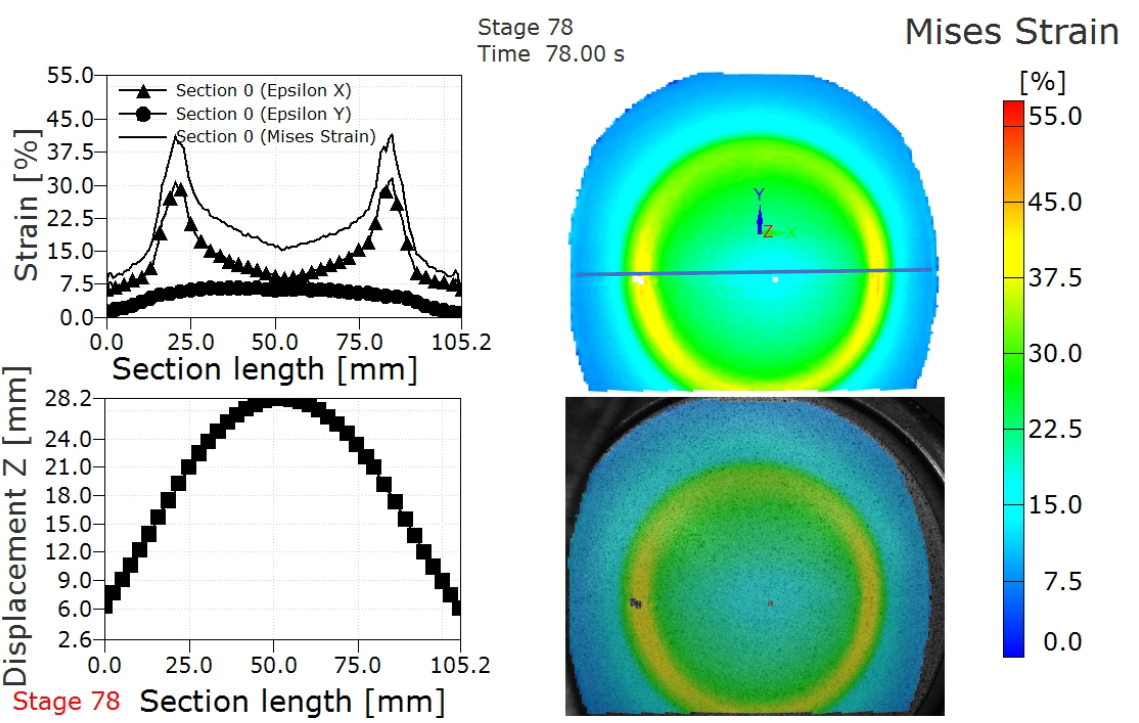
Figure 8. Strain distribution and displacement distribution along the section and Mises strain contour map in the deformed AA5754 tailor-welded blanks with thickness 2.2 mm prior to fracture.